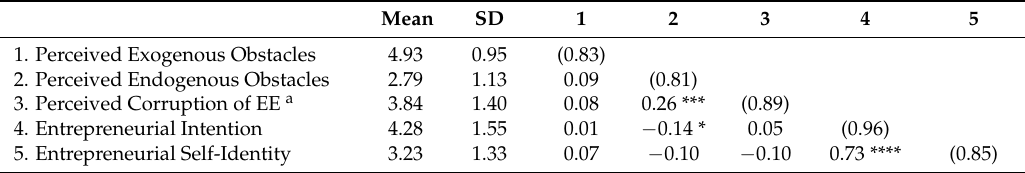
Table 1. Means, standard deviations, coefficient alphas and intercorrelations of the study variables. Mean